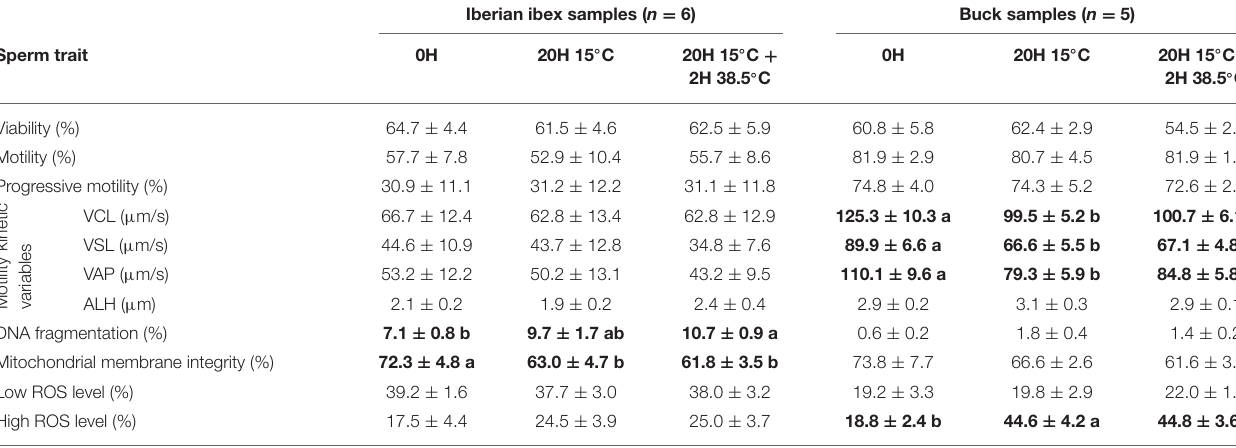
TABLE 3 | Iberian ibex ( Capra pyrenaica ) and buck ( Capra hircus ) sperm quality variables (mean ± SE). Iberian ibex samples ( n = 6) Buck samples ( n = 5) Sperm trait